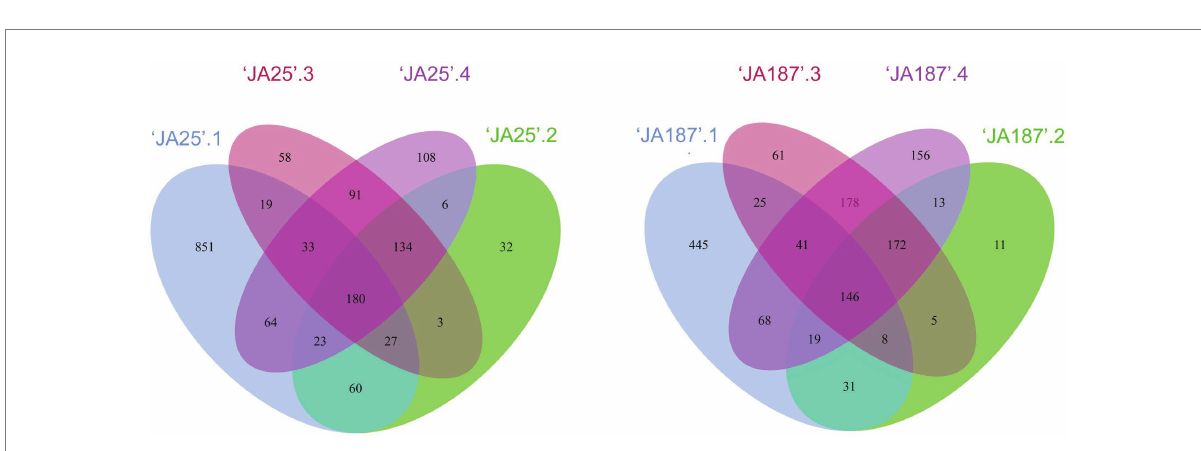
FIGURE 2 Bacterial taxa on the surface of tubers of different Jerusalem artichoke resources during storage. Venn diagram showing OTUs unique to and shared by ‘JA25’ (left) and ‘JA187’ (right) Jerusalem artichoke tuber surfaces. Each circle in the figure represents one sample. The number of overlapping areas represents the number of OTUs shared between the samples. The numbers without overlapping areas represented the number of unique OTUs in the